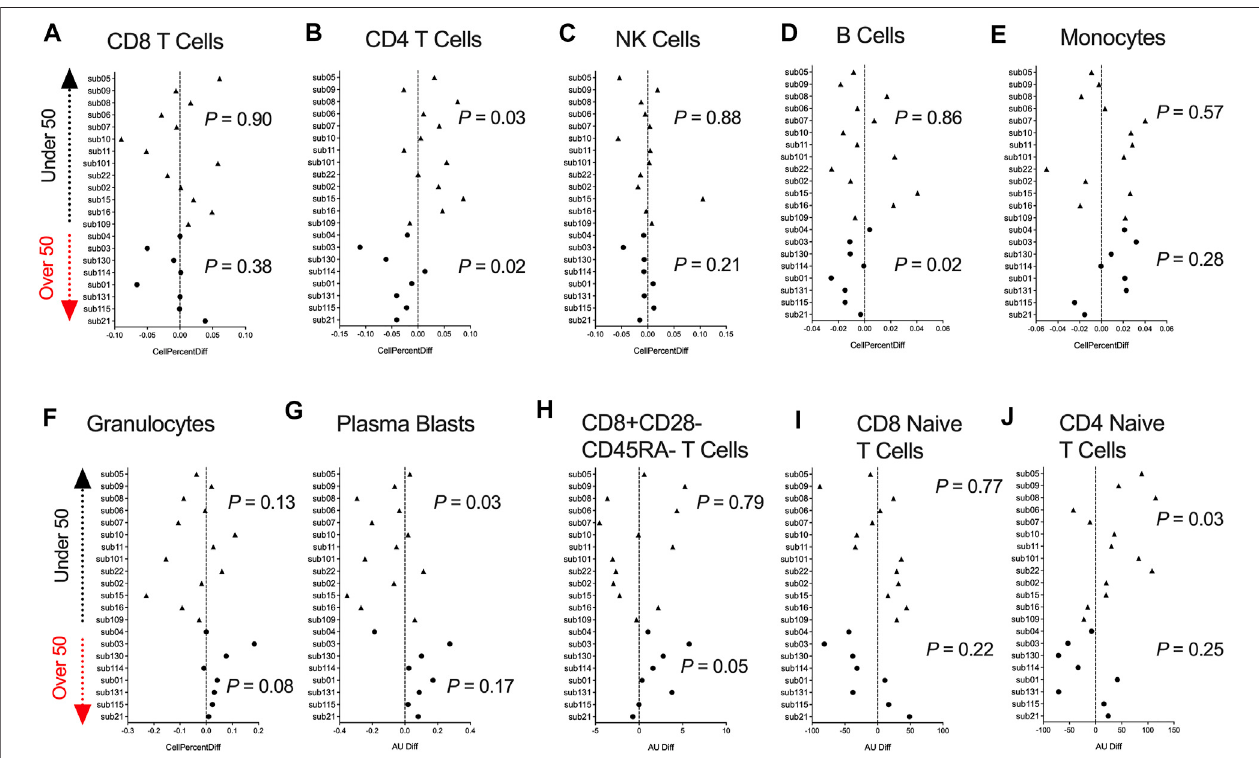
FIGURE 2 | DNA methylation inferred blood immune cell type composition following mild/moderate COVID-19 (A – J) . Plots displaying the change in speci fi c immune cell type populations inferred from DNA methylation in individuals pre- vs. post-COVID-19 strati fi ed by age. Triangles display participants less than 50 years of age and circles display participants over 50 years of